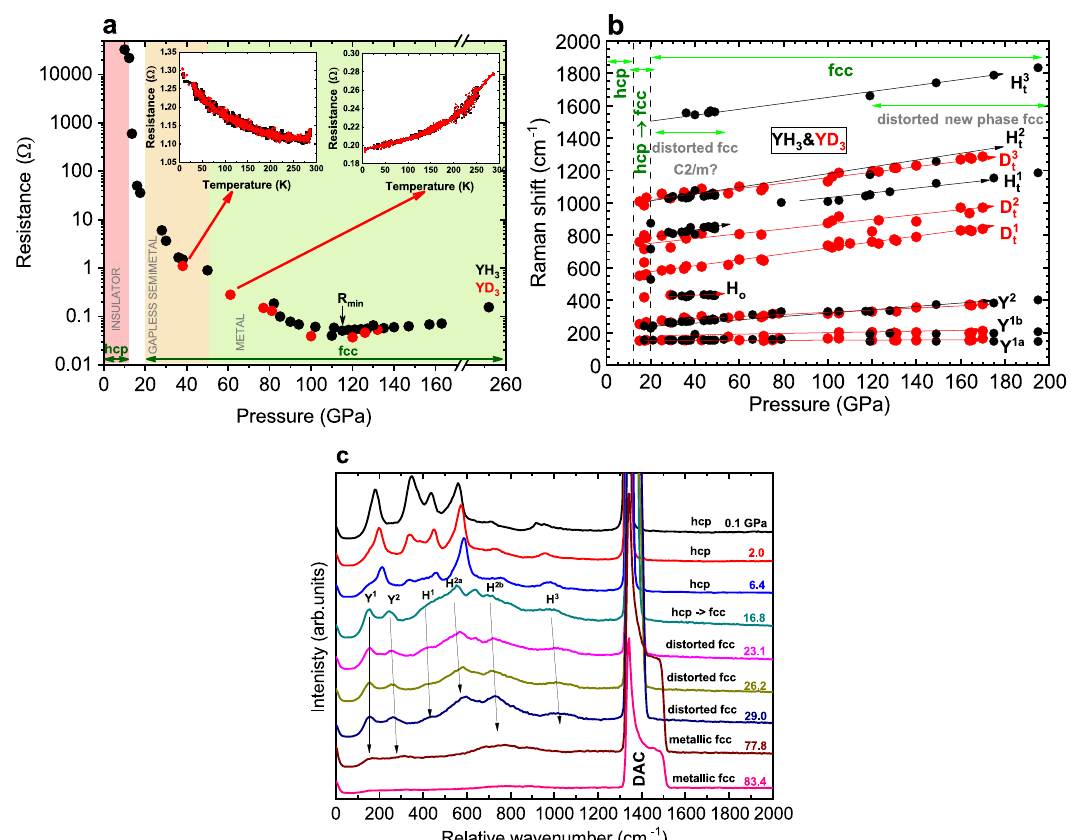
Fig. 4 Resistance and Raman scattering. a Resistance versus pressure for YH 3 (black dots) and YD 3 (red dots). Insets show the temperature dependence of resistance at 38 and 61 GPa; b The dependence of Raman modes shift on pressure for YH 3 and YD 3 ; c The pressure dependence (up to 83.4 GPa) of the Raman scattering in YH 3 .